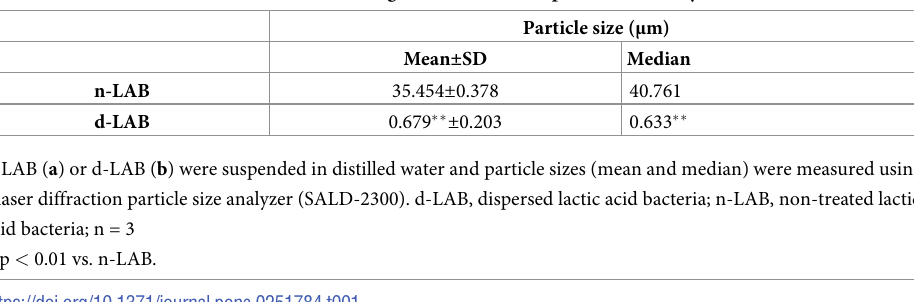
Table 1. Measurement of n-LAB and d-LAB using a laser diffraction particle size